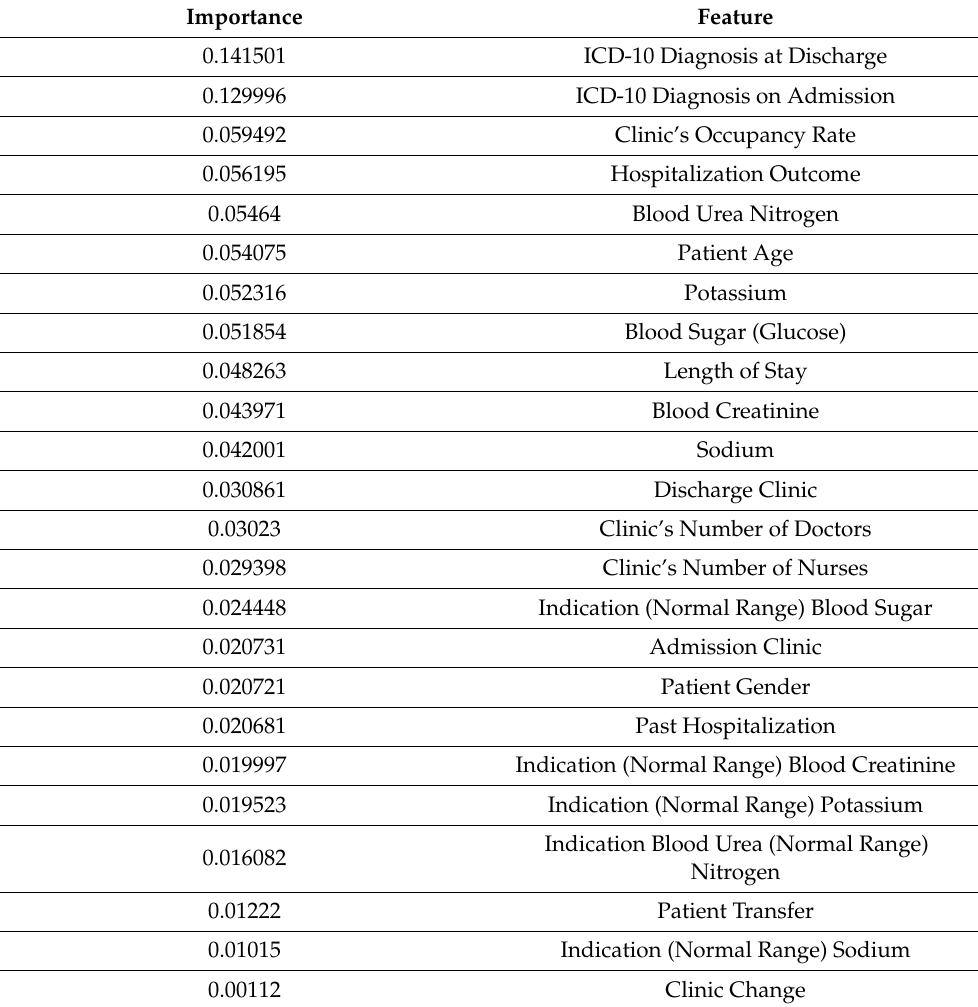
Table 11. Feature importance ranking, the significance of each feature in the classification of the random forest model in decreasing